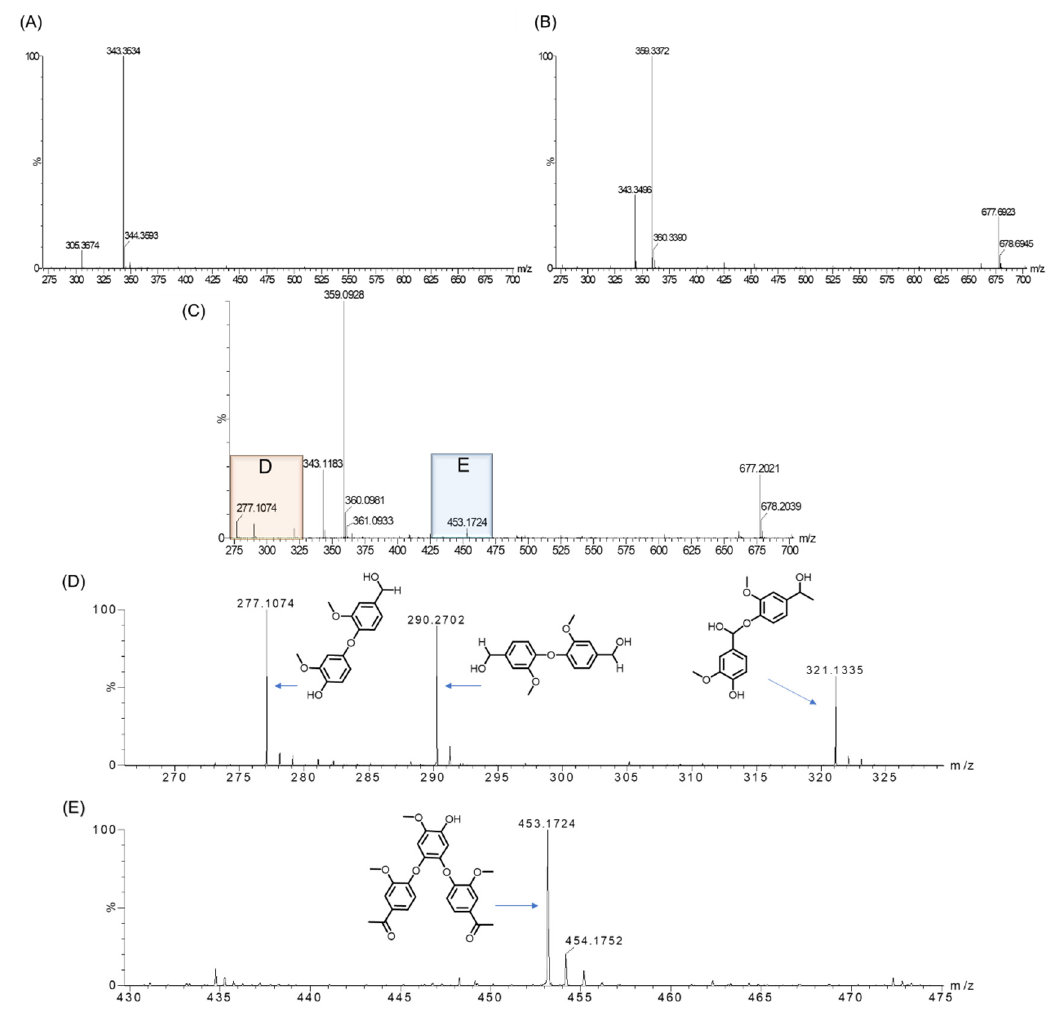
Figure 8. ( A ) ESI-MS spectra of the GGE with the molecular weight of 343 Da. ( B ) After reacting for 0.25 h, two major products were detected with molecular weights of 359 and 677 Da, respectively. ( C ) After reacting for 1 h, four more products were detected, with molecular weights of 277, 290, 321 ( D ), and 453 Da ( E ).